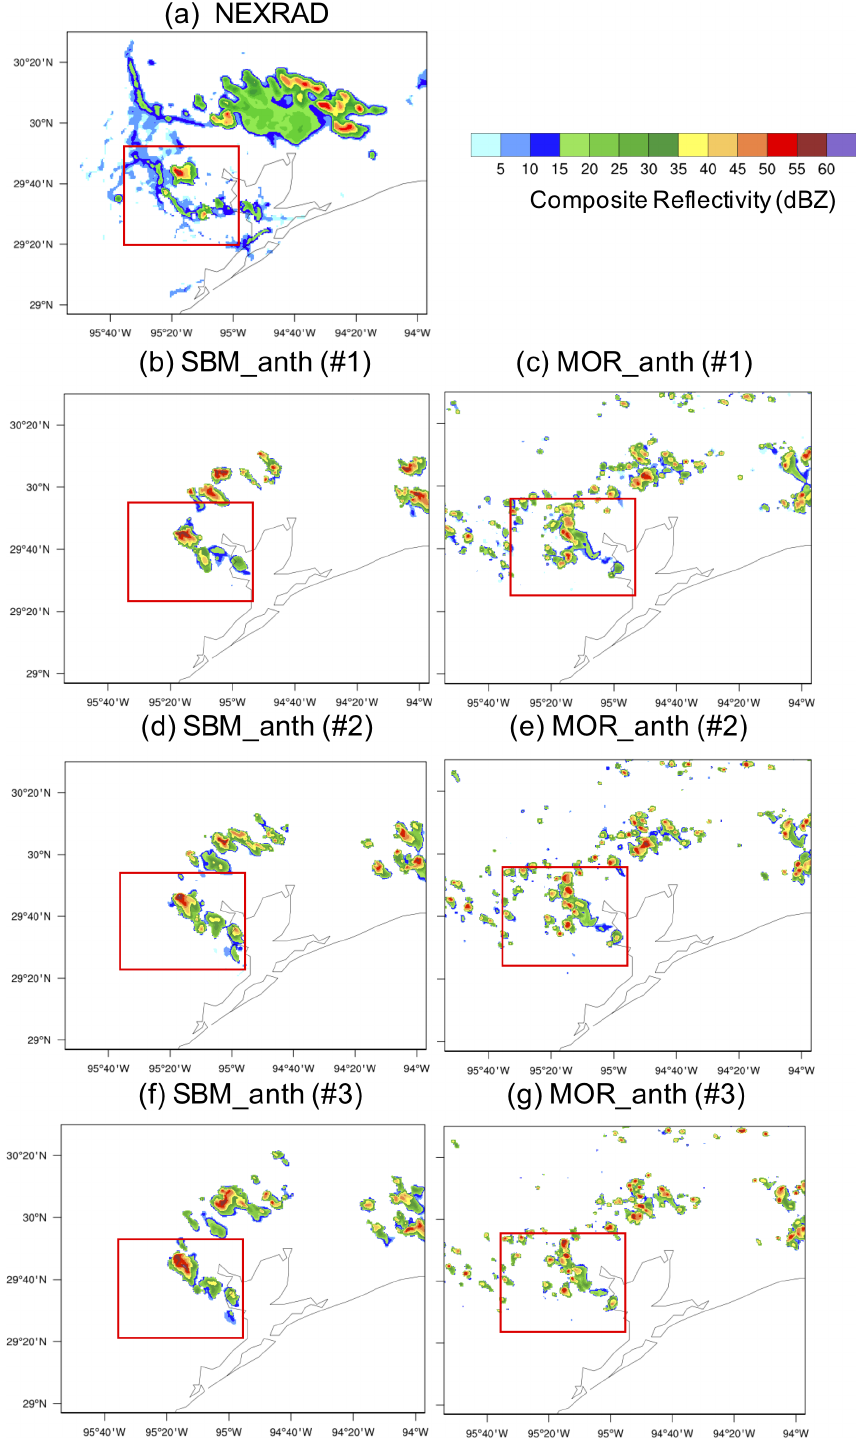
Figure 7. Composite reflectivity (unit: dBZ) from (a) NEXRAD (22:17UTC), (b, d, f) three ensemble runs for SBM_anth (21:40UTC), and (c, e, g) three ensemble runs for MOR_anth (21:25UTC) when maximum reflectivity in Houston is observed on 19 June 2013. The red box is the study area for convection cells near